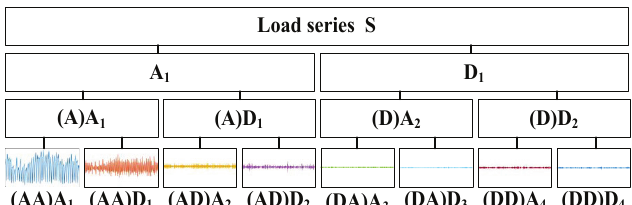
Figure 1. Procedure for signal decomposition using wavelet packet transform